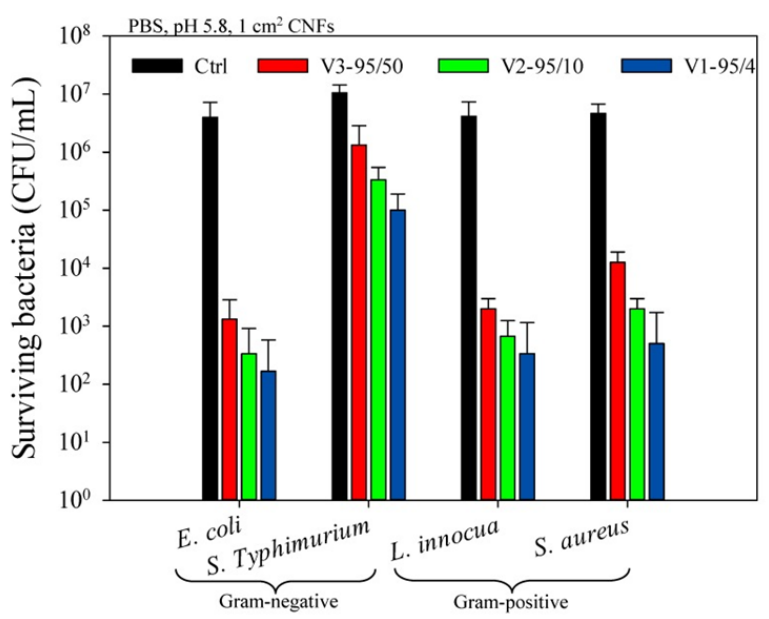
Figure 7. Antibacterial activity of electrospun chitosan/PEO (80:20) nanofibers with different molecular weight against E. coli, S. Typhimurium, L. innocua , and S. aureus . Reprinted from [146], originally published under a CC-BY 4.0 license.